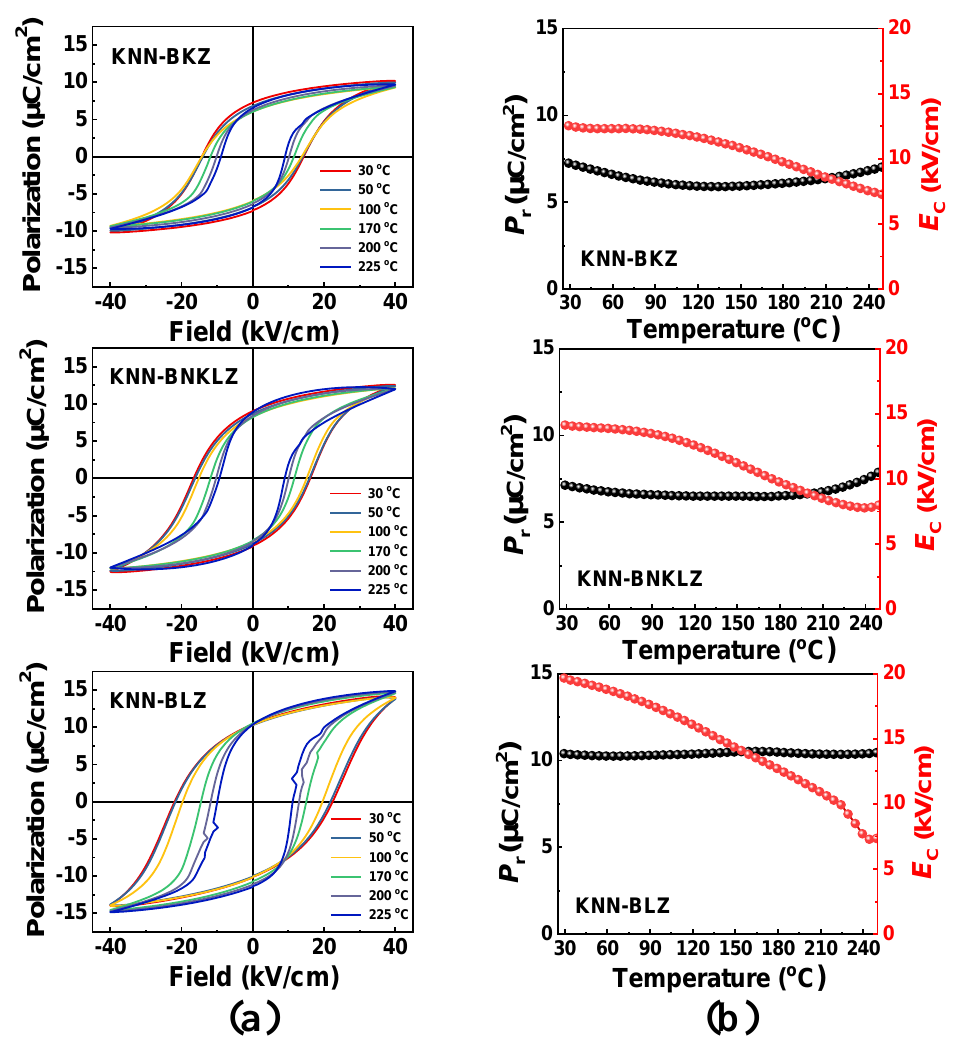
Figure 2. ( a ) Polarization versus electric field ( P–E ) hysteresis loops of the KNN-BKZ, KNN-BNKLZ, and KNN-BLZ ceramics and ( b ) P r and E c values versus temperature.